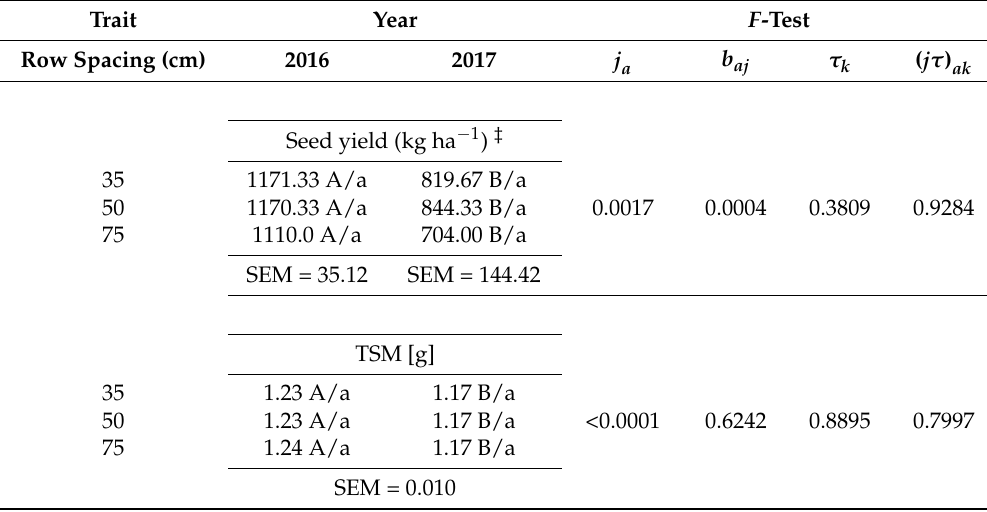
SEM = 0.010 Estimates, average standard errors of the mean (SEM) and p -values from F -tests are based on model (2); j a Annual effect; b aj Block effect; τ k Treatment effect (row spacing); ( j τ ) ak Interaction between treatment and annual effect; Letter display: Estimates at a constant level of the treatment factor that share a capital letter do not differ significantly between years at α = 0.05. Estimates within a year that share a lowercase letter do not differ significantly between treatment factor levels at α = 0.05; ‡ For the marked traits model (2) was extended allowing heterogeneous